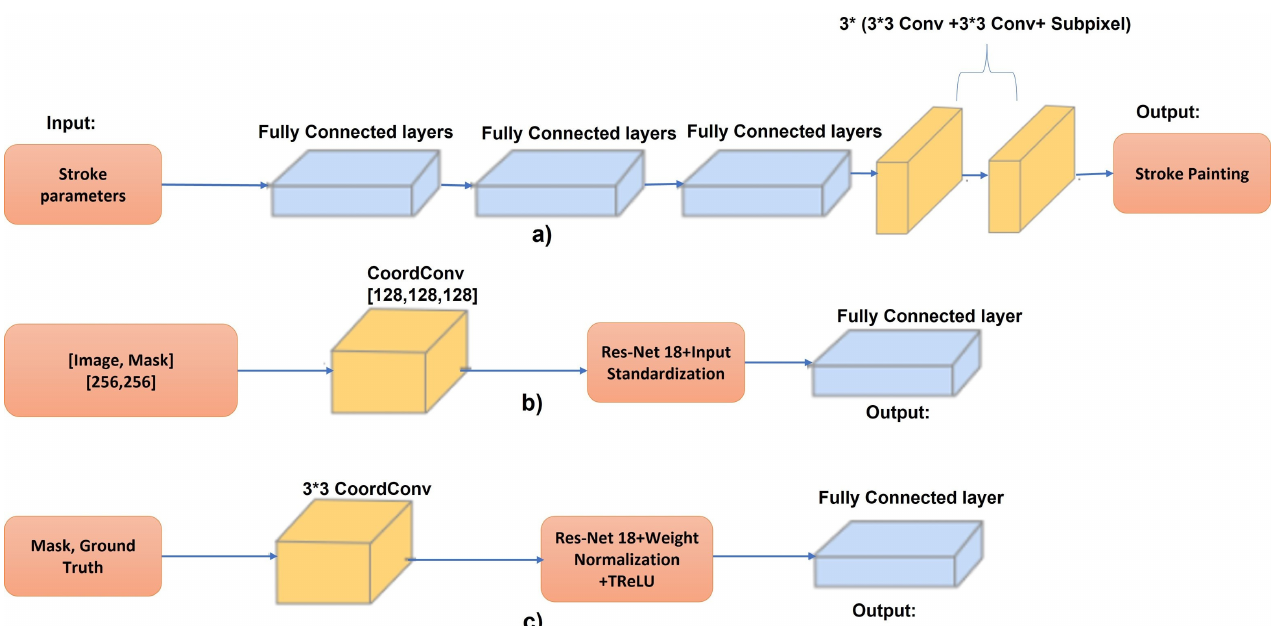
Figure 5. (a) The segmentation executor. ( b ) The actor and ( c ) The critic. The following are the network’s architecture. The segmentation executor produces various segmentation results depending on the parameters taken for action. The action set is output by the actor as a series of five actions at a time, each with 8 parameters. The outputs of the critic are single valued for estimation. ResNet-18 is the architecture used.